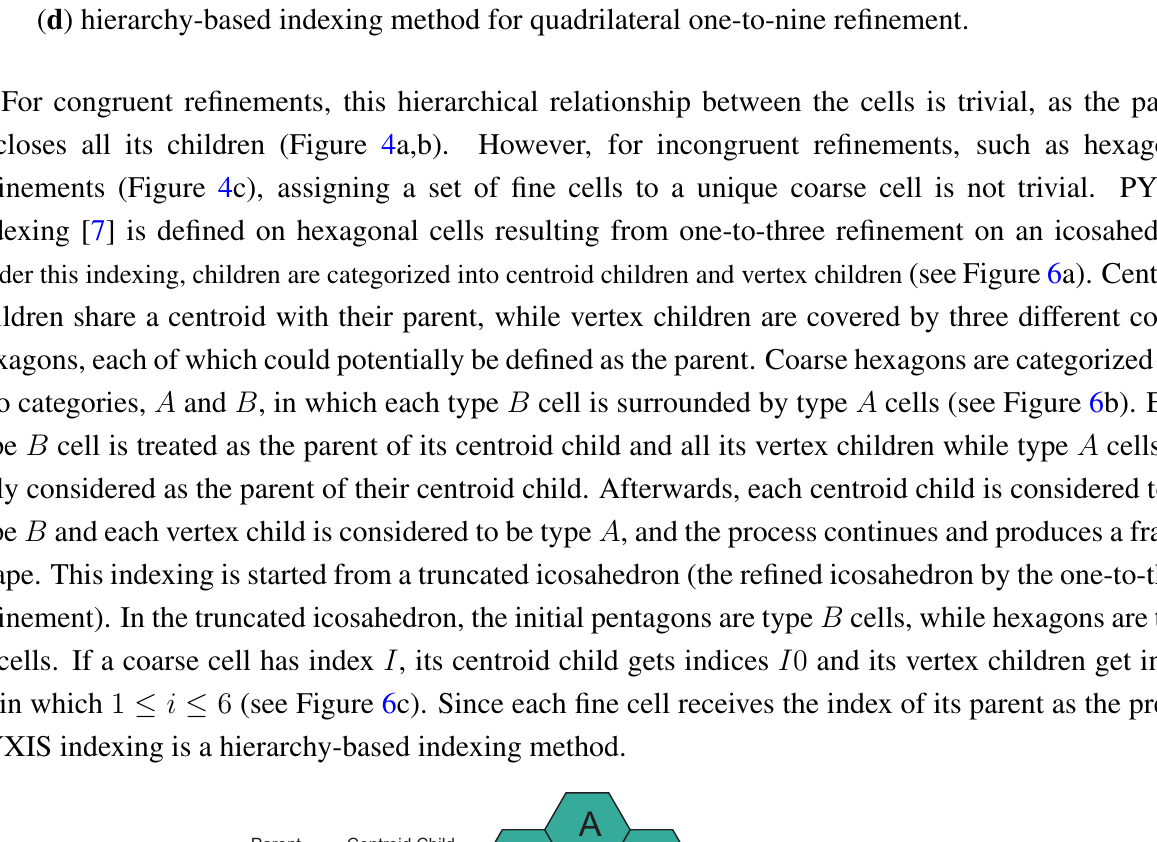
Figure 5. ( a ) Hierarchy-based indexing for one-to-four refinement; ( b ) vectors corresponding to each digit; ( c ) 1D index I003 and its corresponding cell; ( d ) hierarchy-based indexing method for quadrilateral one-to-nine refinement.